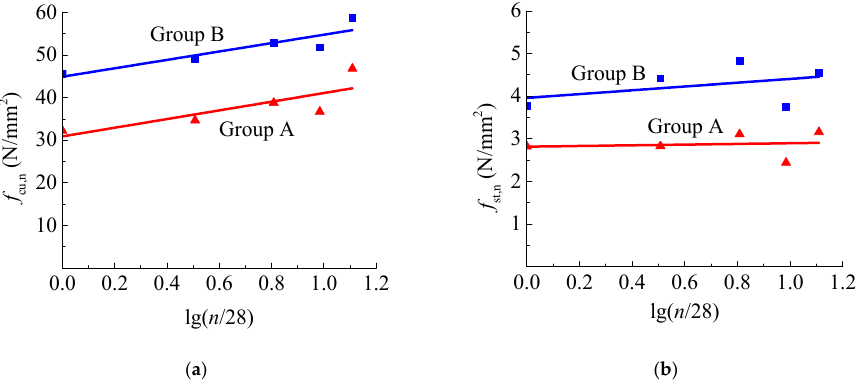
Figure 8. E ff ect of soaking time on ( a ) compressive strength; ( b ) splitting tensile strength. Figure 8. Effect of soaking time on (a) compressive strength; (b) splitting tensile strength.